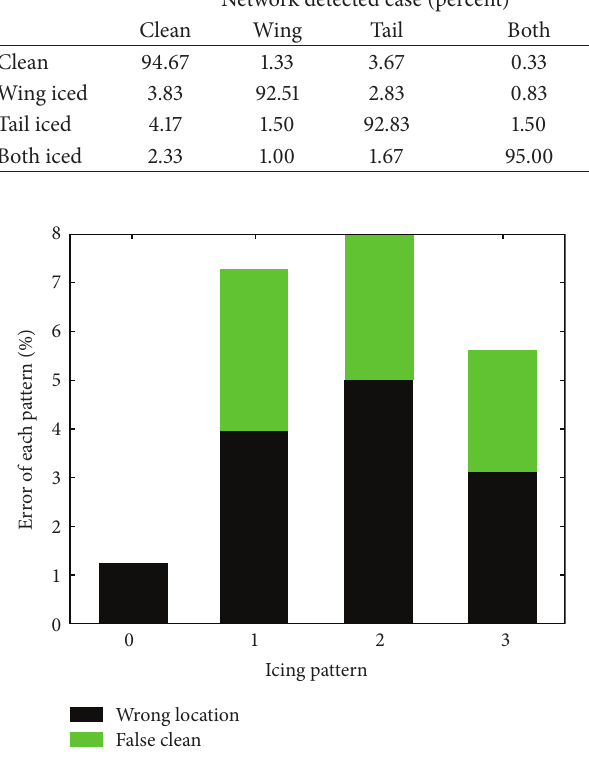
Figure 6: Network test error for each icing